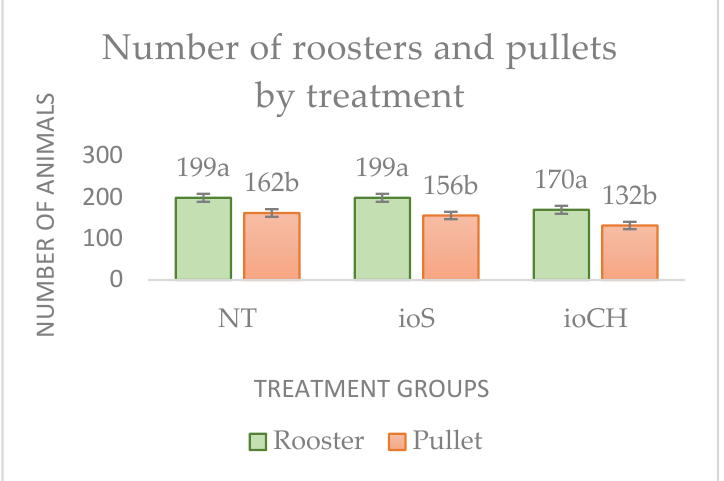
Figure 1. Distribution of hatched chicks by treatment ( p < 0.001) and sex ( p < 0.001): NT, control group; ioS, in ovo saline (NaCl); ioCH, in ovo carbohydrate solution. Different letters (a, b) represent significant differences among treatment